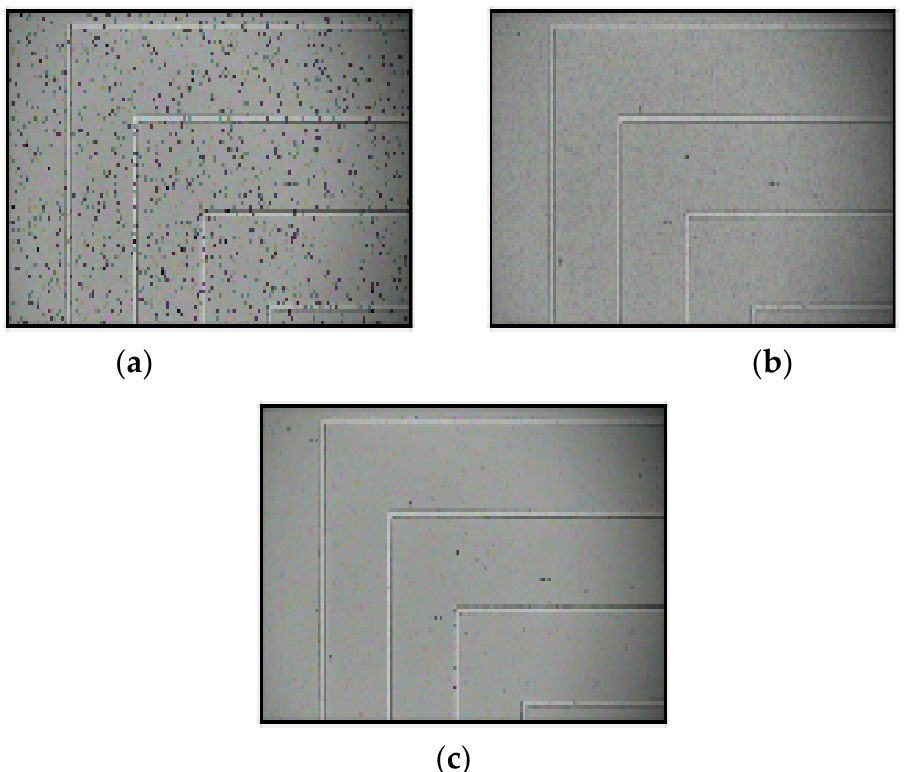
Figure 6. Effect picture of filtering and denoising: ( a ) original image, ( b ) median filter denoising, and ( c ) mean filter denoising.